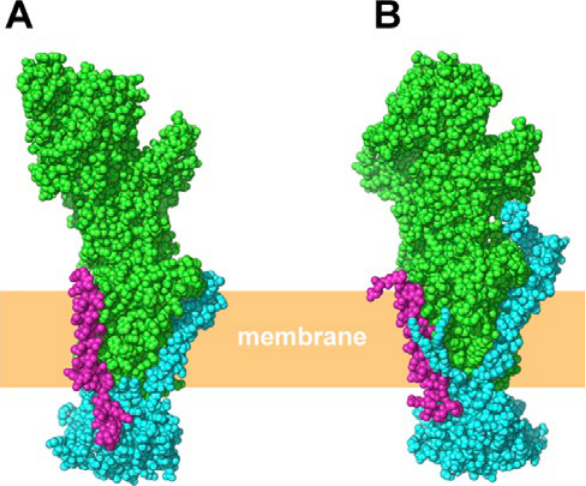
Figure 5. Crystal structure of the Na,K-ATPase in two conforma- tions. The ion pump consists of the α (green), β (cyan) and an regulatory FXYD subunit (magenta). A: E 2 conformational state with 2 K + bound in a E 2 P-like state in which phosphate is replaced by MgF 42- (pdb ID 2ZXE). 101 The analyzed crystal had a resolu- tion of 2.4 Å. The enzyme was isolated and purified from shark rectal glands. It contains FXYD10 as regulatory subunit. B: Tran- sition state of the Na,K-ATPase preceding the E 1 P conformation with 3 Na + ions occluded after binding from the cytoplasmic side (pdb ID 3WGU). 115 The analyzed crystal had a resolution of 2.8 Å. The enzyme was isolated and purified from pig kidney. It contains FXYD2 as regulatory